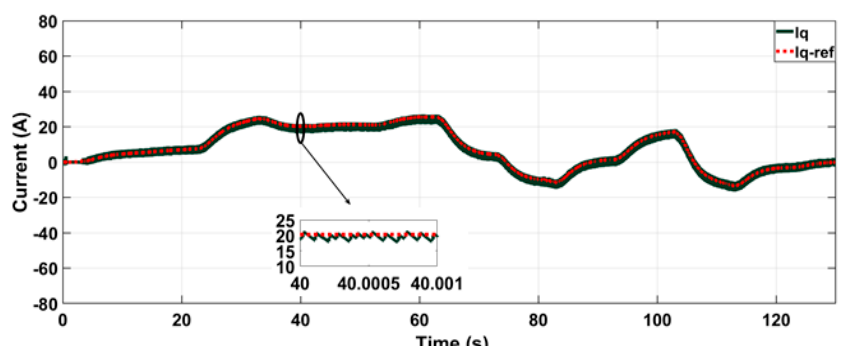
Figure 7. Motor torque and reference.